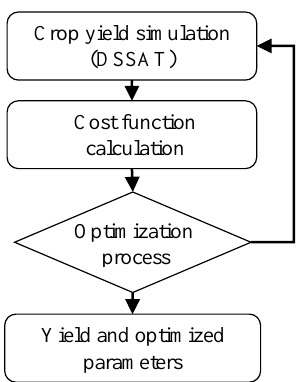
Figure 2. Flowchart of the methodology used in this study for simulating rice yield using DSSAT in the study